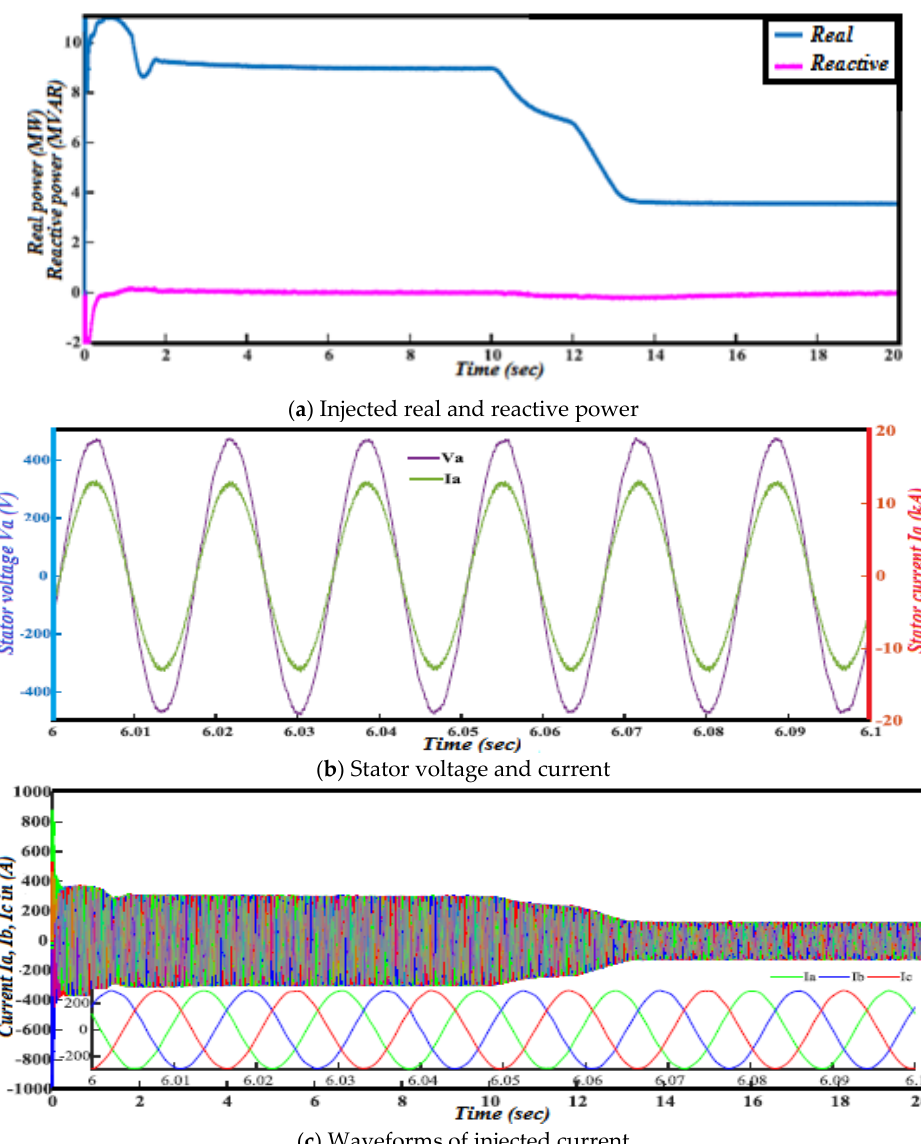
Figure 17. System performance of wind.